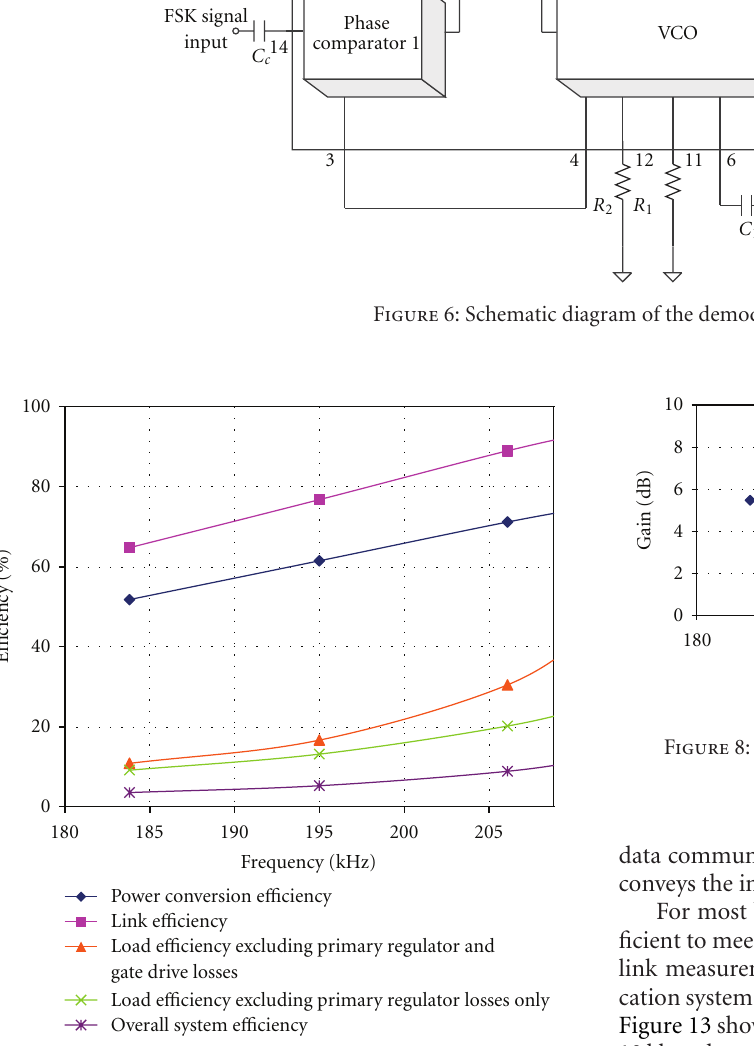
inductance at all between the coils, and output voltage drops to zero. The test results are shown in Figure 11(b).